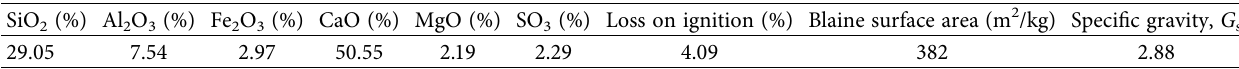
Table 5: Main chemical composition and performance of Portland cement (42.5).